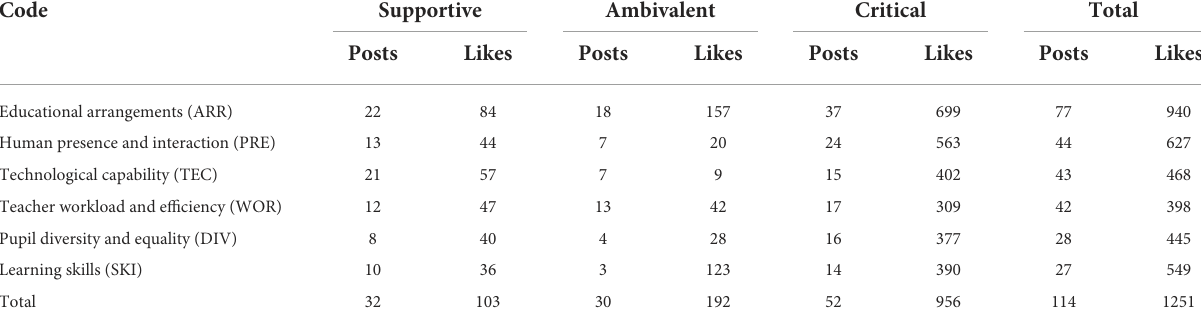
TABLE 2 Number of posts and sum of likes by code and perspective toward the